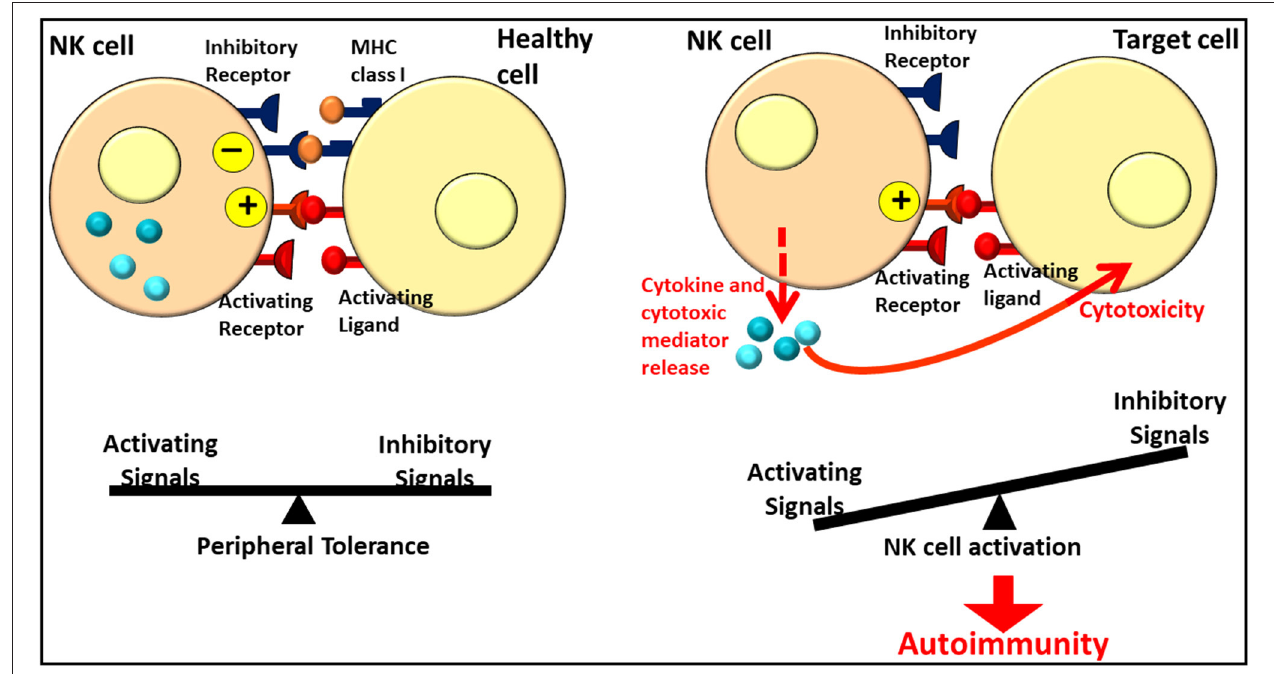
FIGURE 1 | Role of NK cells in homeostasis and autoimmunity. Figure adapted from Ref. (12). NK, Natural Killer.